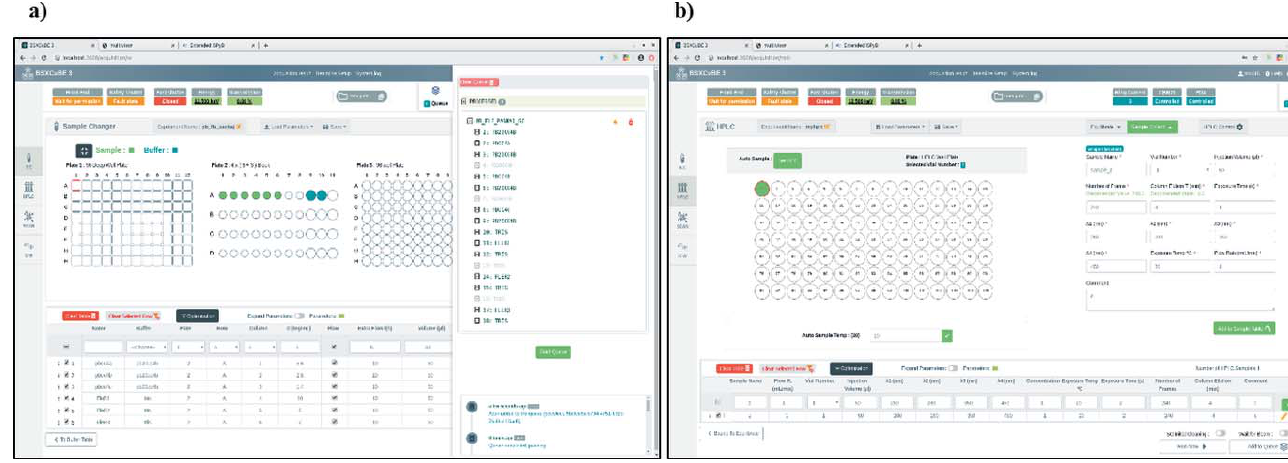
Figure 6 BSXCuBE3 data acquisition modes. ( a ) Sample changer and ( b ) SEC-SAXS